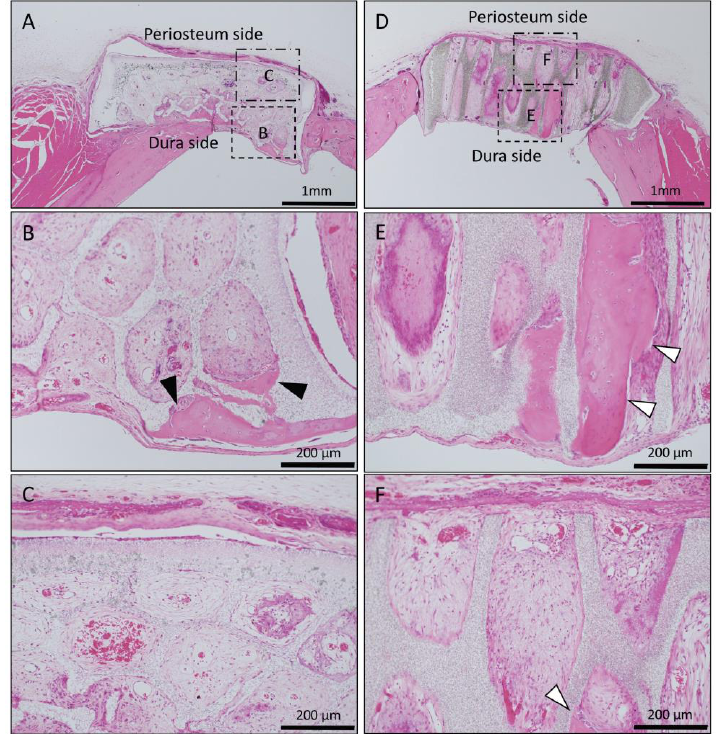
Figure 5. Histological images of β-TCP with Collagen gel alone at 4 weeks after implantation. ( A ) Low-magnification image of horizontal β-TCP. No inflammatory granulation tissue was observed around β-TCP. ( B , C ) Higher-magnification image of corresponding outlined area in (A). Inflammatory cell infiltration was poor in all of the TCP holes, and vascular invasion was observed. Only a small amount of bone tissue was found near the dura (black arrowheads), and the formation of bone tissue was not found in the holes near the periosteal side. ( D ) Low-magnification image of vertical β-TCP. No inflammatory granulation tissue was observed around β-TCP. ( E , F ) Higher- magnification image of corresponding outlined area in (D). The formation of bone tissue was observed in some through-holes of the dura side (white arrowheads); however, no bone tissue formation was observed in the periosteum side. In the case of the Collagen gel-loaded (with BMP-2) horizontal honeycomb β-TCP, bone tissue formation was observed from the dura side to the periosteum side as if it was added to the inner wall of the hole; however, new bone formation in the horizontal through-holes was rougher than in the vertical through-holes, and there was no bone marrow-like tissue in the horizontal holes (Figure 6A– C). In Collagen gel-loaded (with BMP-2) vertical honeycomb β-TCP, all holes were filled with vigorous new bone, and the formation of bone marrow-like tissue and vascular cavity was observed in the area surrounded by the new bone tissue (Figure 6D–F).